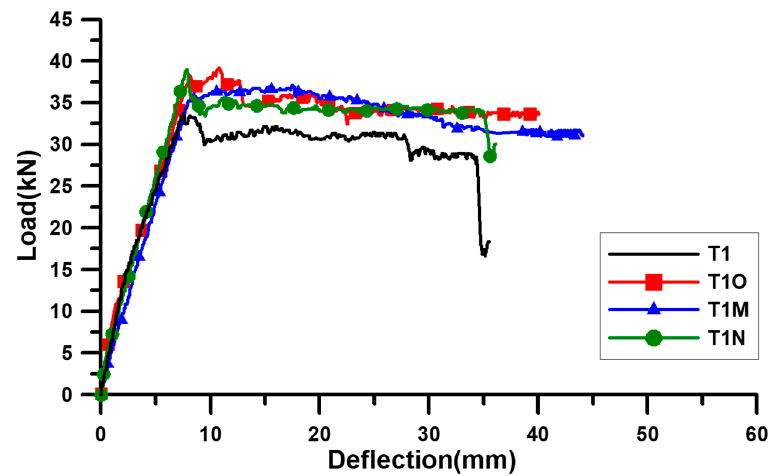
Figure 9. Load and deflection curve: Textile lamination and geometry.